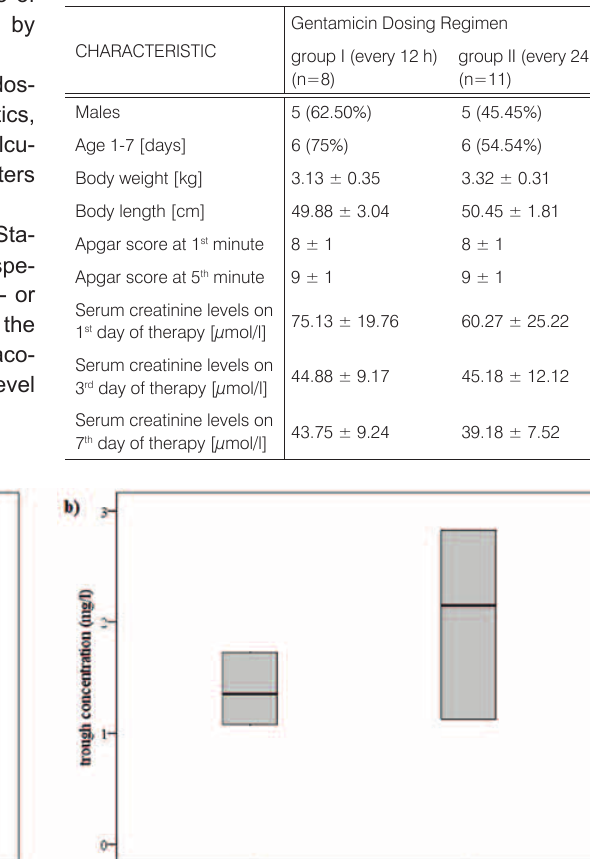
Table 1. Demographic characteristics of neonatal patients